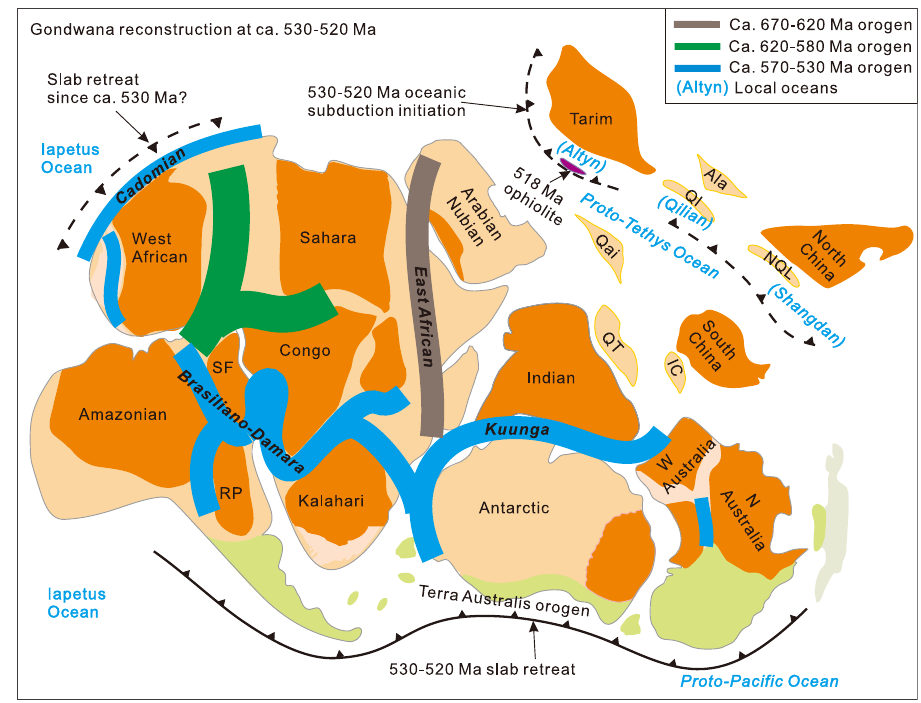
Fig. 6 Reconstruction of Gondwana and subduction zones in its southern, western, and northern margins (revised based on) 13 – 16,63 . Ala , Alashan; Ql , Qilian; Qai , Qaidam; QT , Qiangtang; NQL , North Qinling; IC , Indochina; SF , São Francisco; RP , Río de La